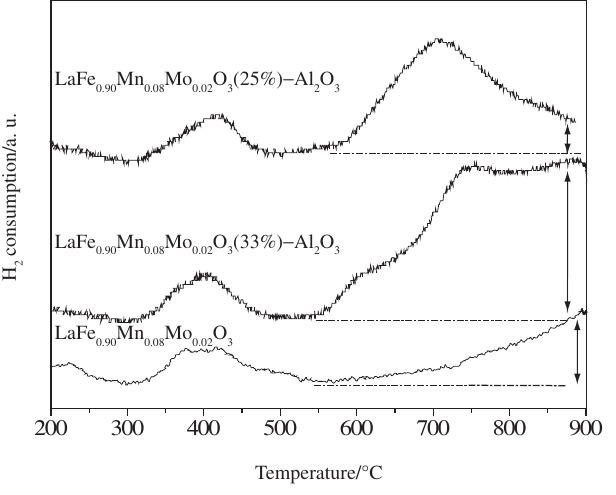
Figure 6. Temperature programmed reduction (TPR) profiles for the perovskite LaFe